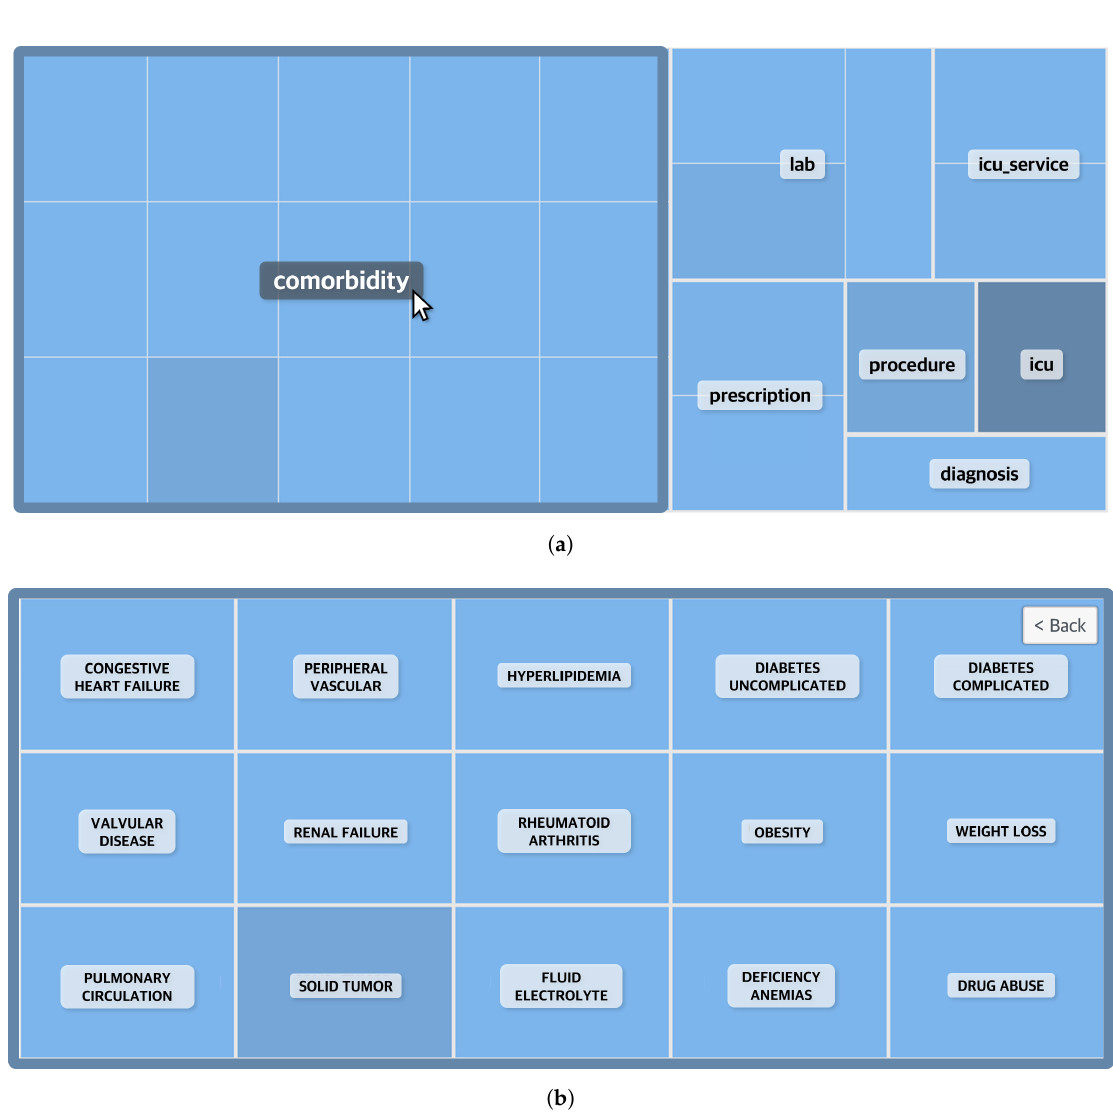
Figure 5. Visualization of the top 25 attention values of the in-hospital congestive heart failure diagnostic prediction model with a TreeMap. ( a ) Events are grouped by category. Selecting a category shows the name of the detailed events. ( b ) A detailed event screen that appears when the category “comorbidity” is